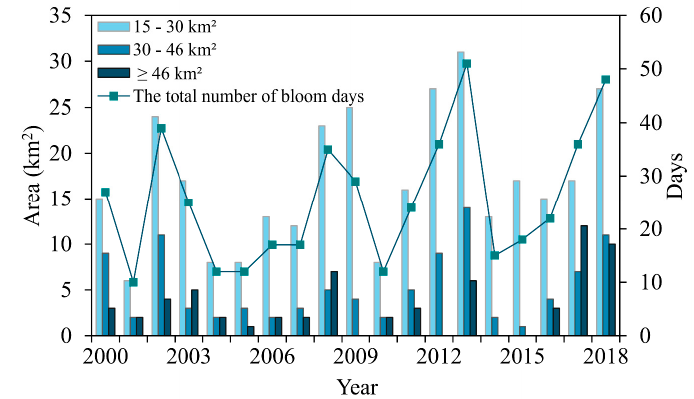
Figure 9. Duration in days for algal blooms with different areas in Lake Dianchi during 2000–2018.